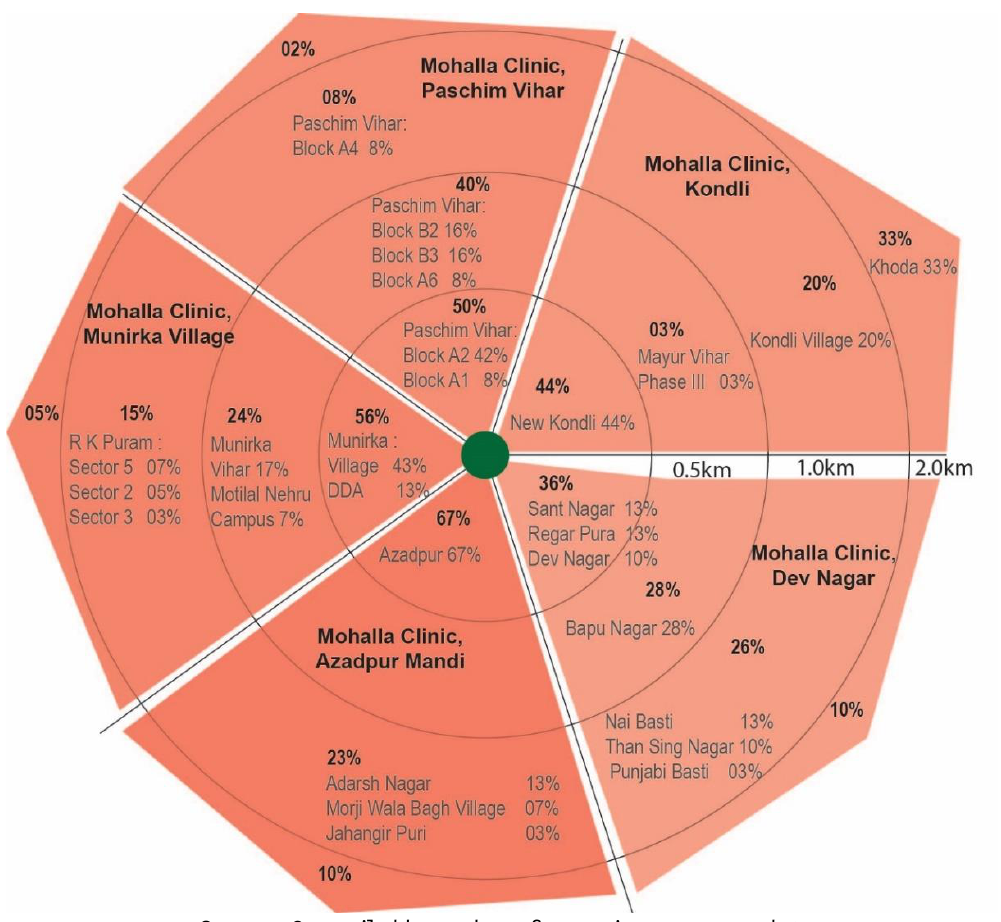
Figure 15: Localities from which users come to Mohalla